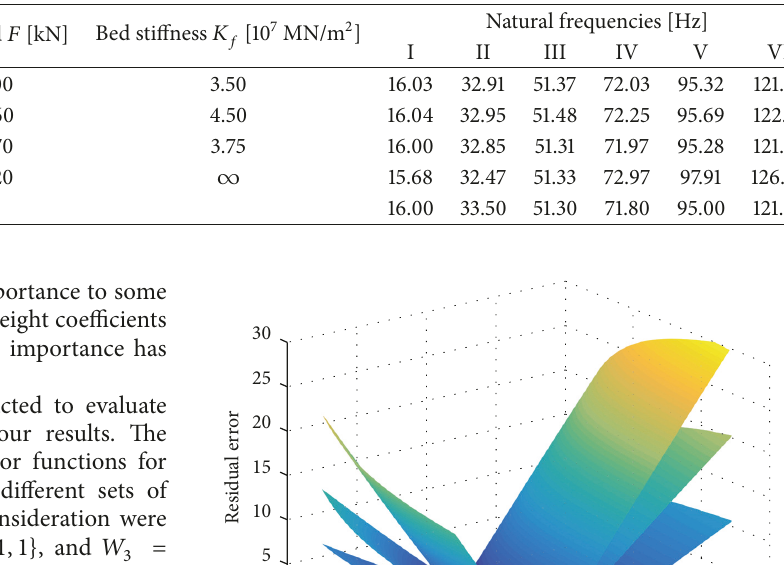
Figure 8: Average stress state in tie-rods: comparison between encastr´e and elastic foundation boundaries. Table 3: Results of computation with three sets of weights for the tie-rod PT4.